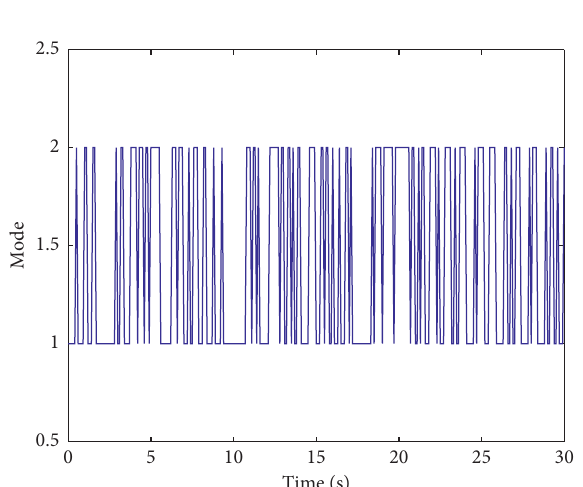
Figure 3: The state response in Case 1. Figure 6: The “event-triggered” release instants and interval in Case